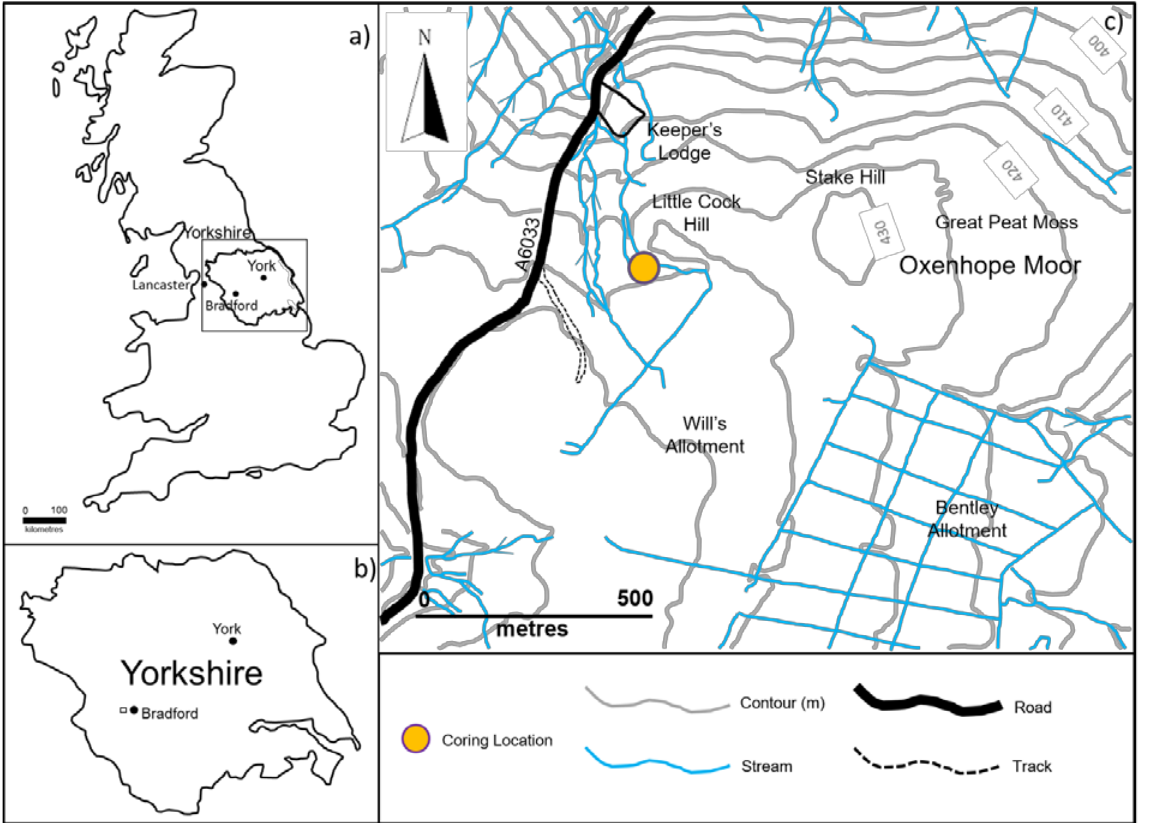
Figure 1. a) Map of United Kingdom showing the locations of Yorkshire (a county) and the cities of Lancaster, Bradford and York. b) Map of Yorkshire; the small square west of Bradford indicates the extent of Map c), i.e. the location of Oxenhope Moor. c) Map of Oxenhope Moor showing the exact coring location at Latitude: 53.793759 ºN, Longitude: 1.977952